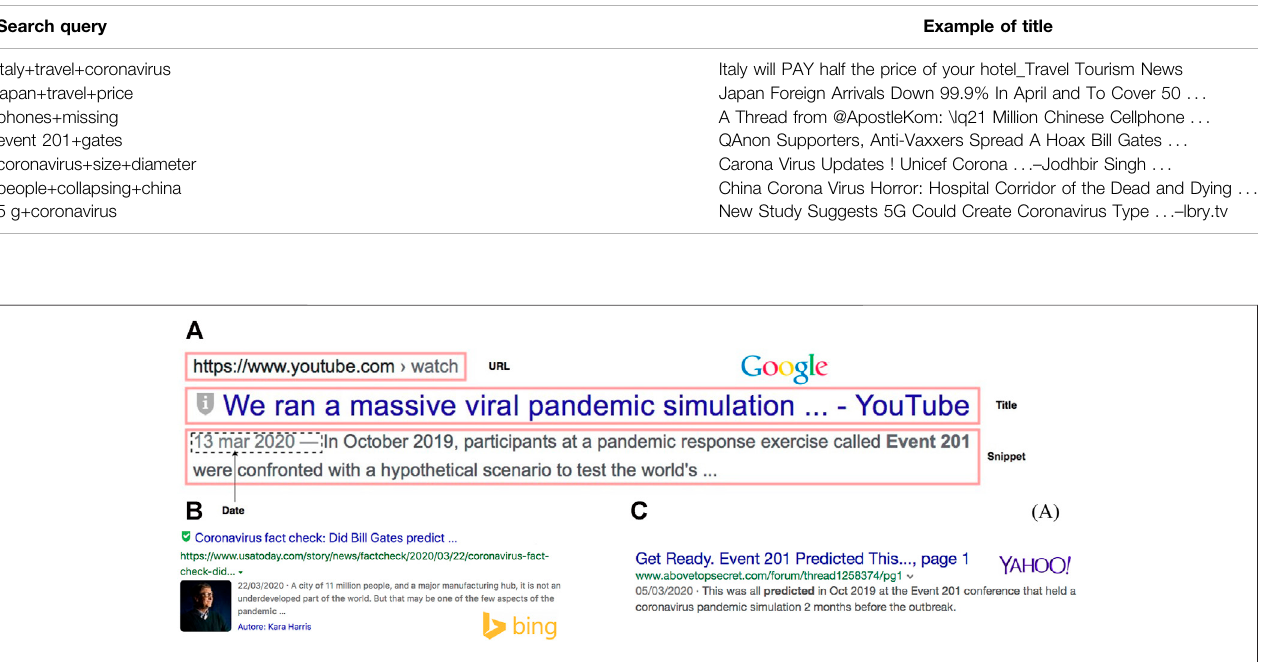
FIGURE 1 | Example of search results on some of the most popular web search engines: Google (A) , Bing (B) , and Yahoo! (C) . The most important meta tags displayed by the search engines results pages, in response to user queries, are title, description (or snippet), date, and cached URL. Panel (A) is scaled up in order to highlight the meta tags (in red rectangles) extracted during data